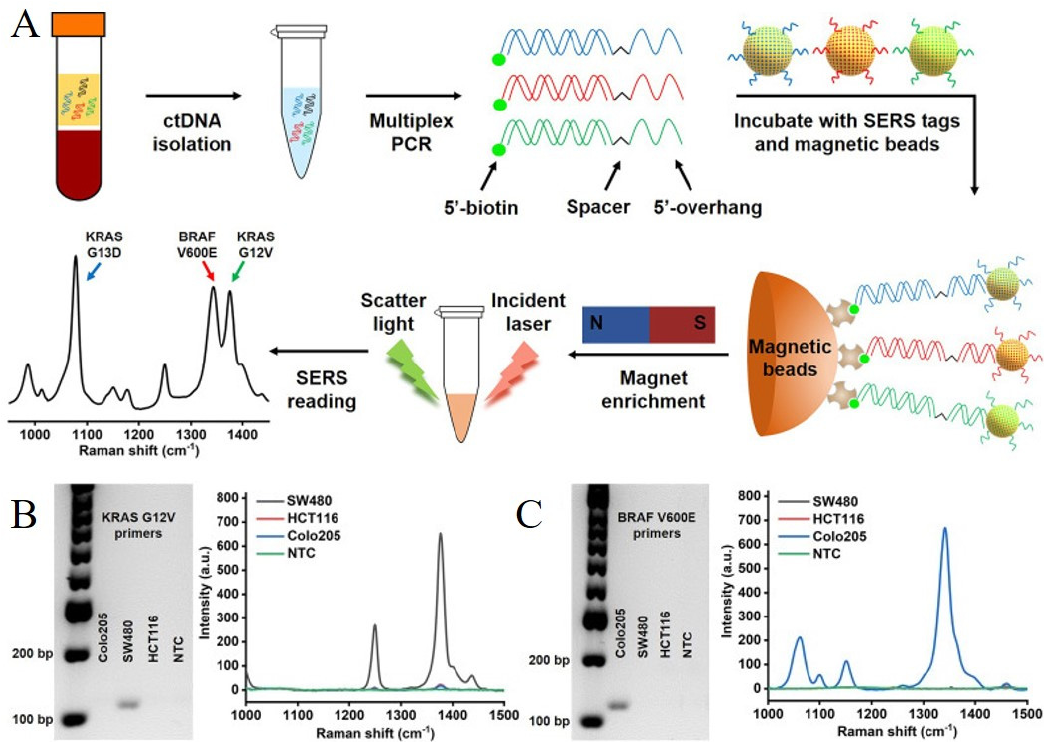
Figure 7. ( A ) Scheme of the multiplex PCR/SERS assay. Multiplex mutation-specific primers were used to amplify mutant targets (the wild-type dsDNA is shown in black). Amplicons were then labelled with mutation-specific nanotags and enriched with streptavidin magnetic beads. The status of mutations was then analysed with SERS spectrum where unique spectral peaks demonstrated the presence of targeting mutations; ( B , C ) Left: Gel electrophoresis verified the specific amplifica- tion of the mutant gDNA with the corresponding individual primers, where no amplification of the wild-type gDNA was observed. Right: Specific detection of individual mutant PCR products with